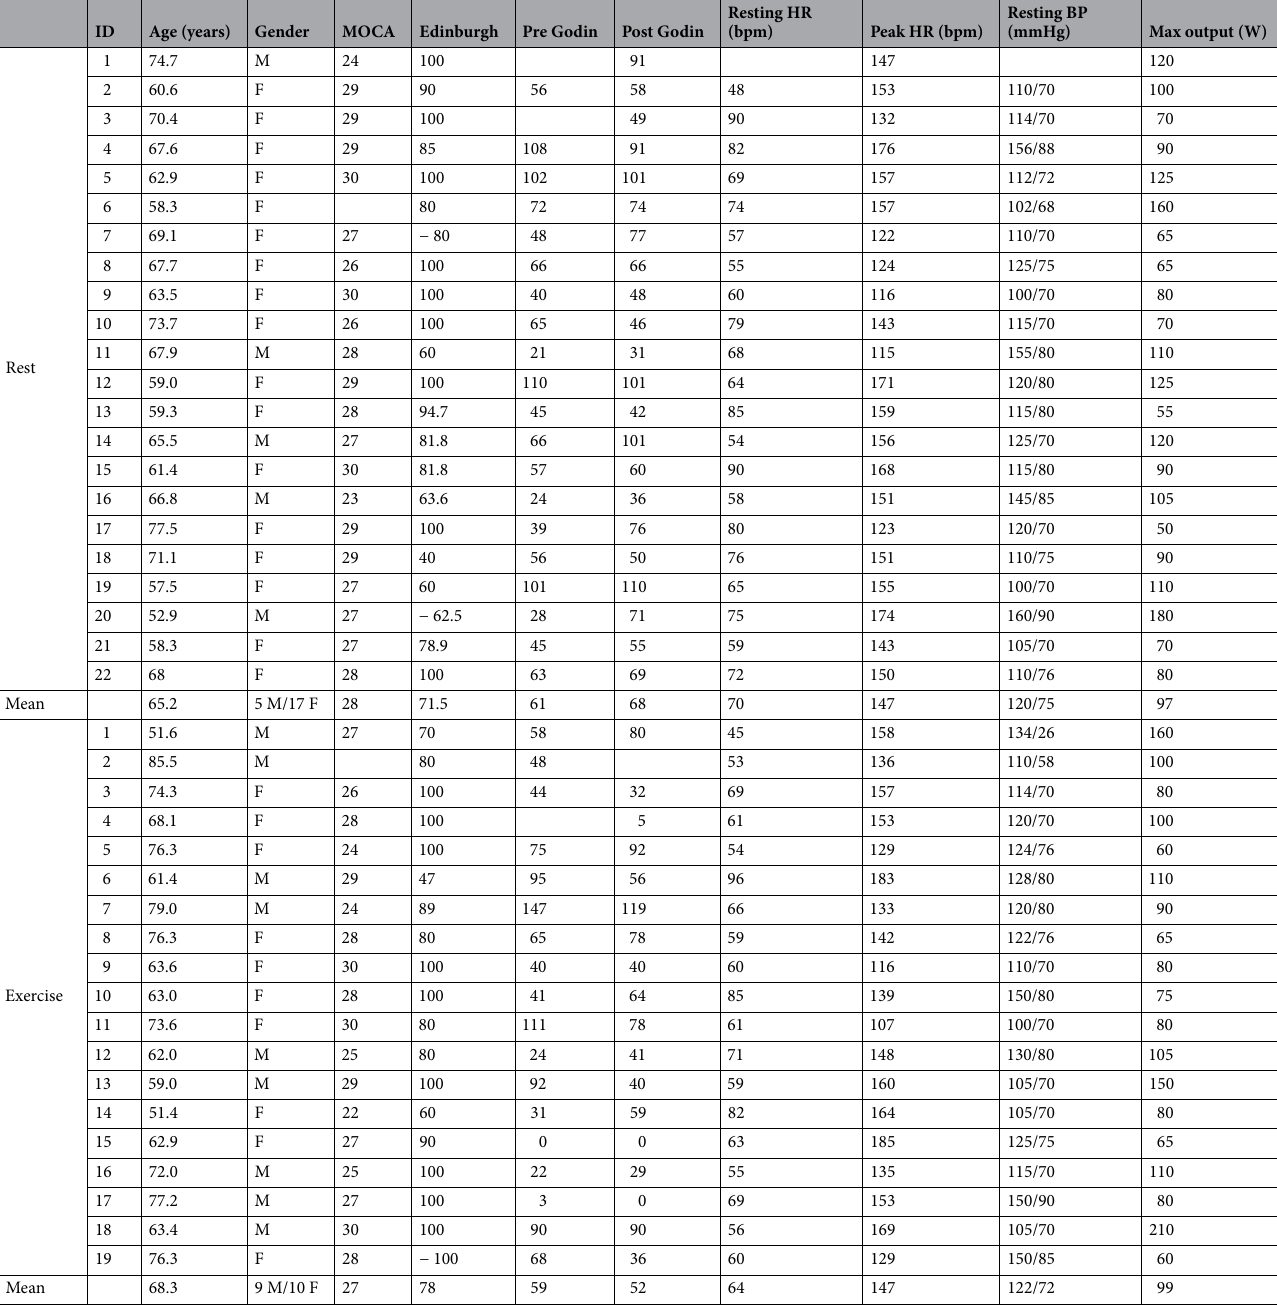
Table 1. Participant demographic table. Resting heart rate (HR), peak HR, resting blood pressure (BP), and max output in watts (W) are values taken from the stress test. Blank fields indicate missing